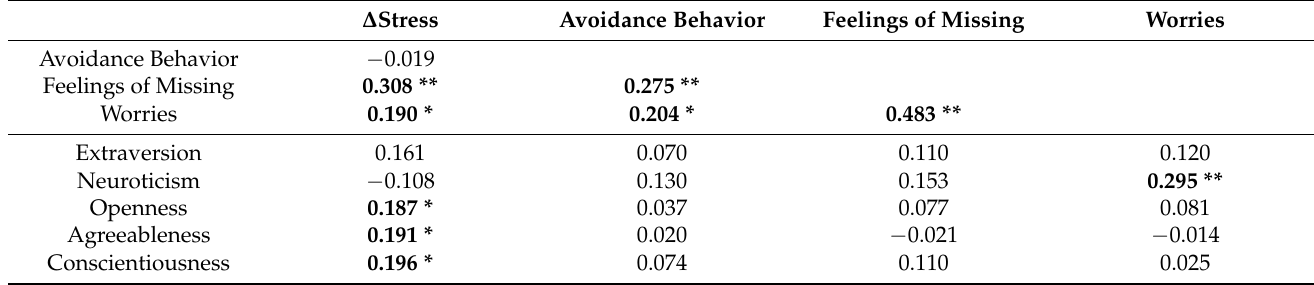
Table 2. Pearson-correlation coefficients of changes in perceived stress ( ∆ stress), “avoidance behavior”, “feelings of missing”, “worries”, as well as big five personality traits, significant correlations are printed in bold.